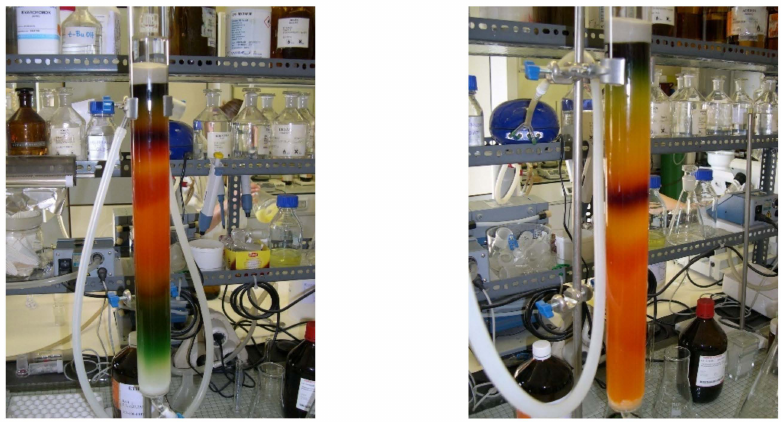
Figure 3. Column chromatography of an alga extract on modified silica